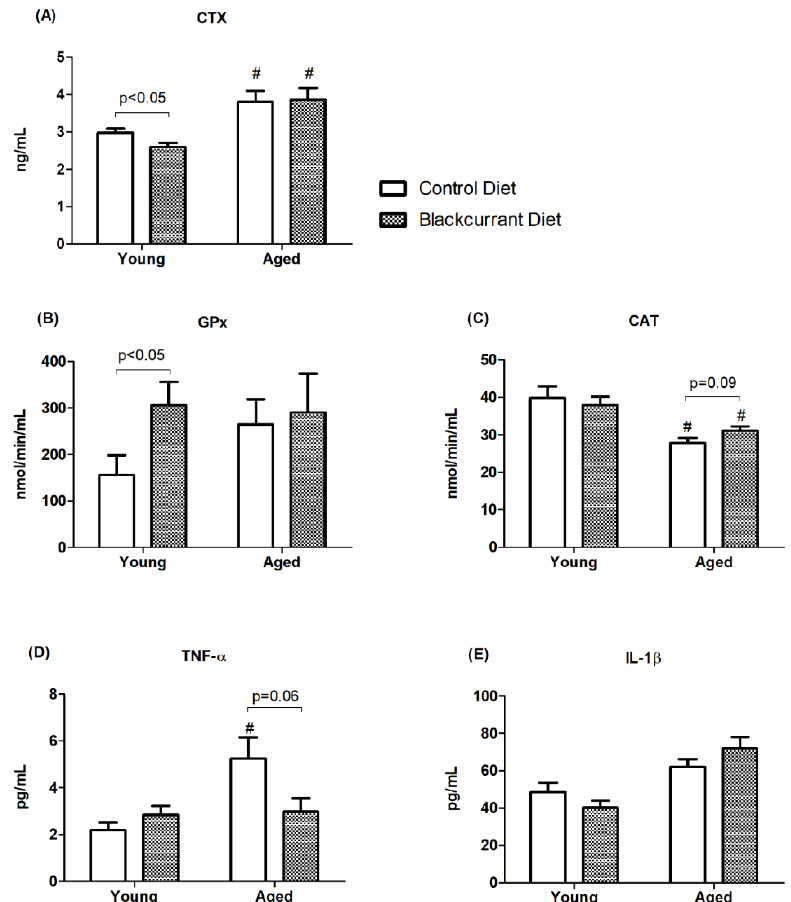
Figure 6. Bone homogenate biomarkers measured in young and aged mice consuming a control or blackcurrant (1% w / w ) diet for 4 months. ( A ) Bone resorption marker CTX. ( B , C ) Antioxidant enzyme activity. ( D , E ) Pro-inflammatory cytokines. Values are reported as mean ± SEM. Data were analyzed using an independent t -test. Young control ( n = 10), young BC ( n = 10), aged control ( n = 8), and aged BC ( n = 7). # Indicates significant difference by age in mice consuming the same diet. CTX, C-terminal telopeptide of type I collagen; GPx, glutathione peroxidase; CAT, catalase; TNF- α , tumor necrosis factor α ; IL-1 β , interleukin-1 beta.